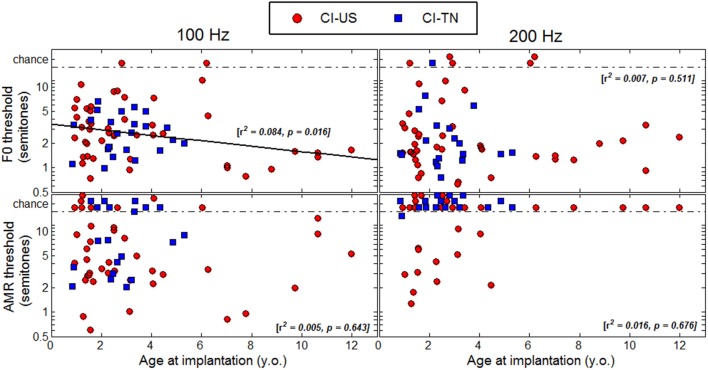
Thresholds as a function of age at implantation.